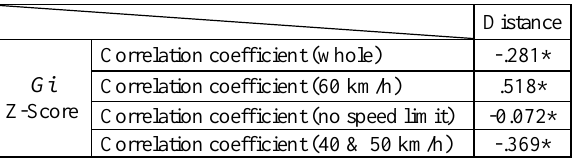
Table 1. Correlation coefficient between two variables